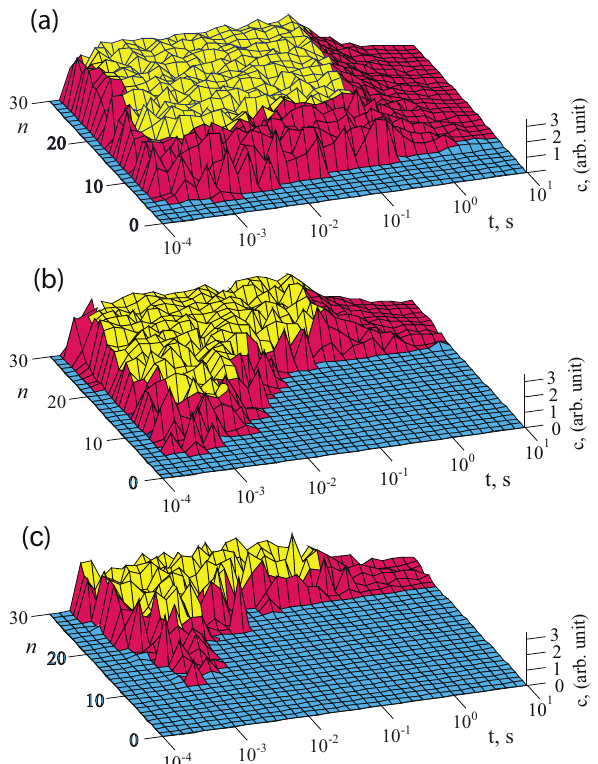
Figure 2. Dependences of the number of charges at the ends of non-point dipoles on the change of the time of the external excitation at the frequency Ω = 13 Hz and the length of the chain with dipole radius r = 10 nm and spacing 2 a = r for the strengths of the external alternating fields E = 10 5 V/m ( a ), E = 10 0 V/m ( b ) and E = 10 − 6 V/m ( c ). The excitation field was switched off at the instant of time t ≥ 1 × 10 − 3